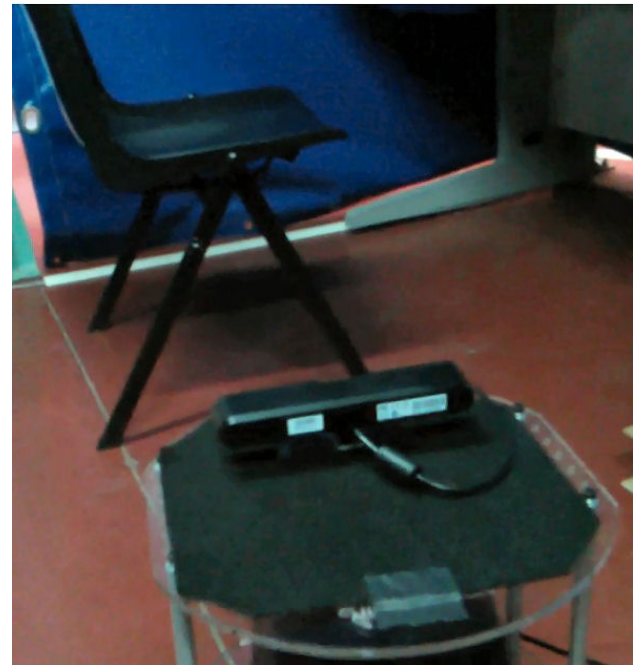
Figure 15. Moving robot and detecting chair.